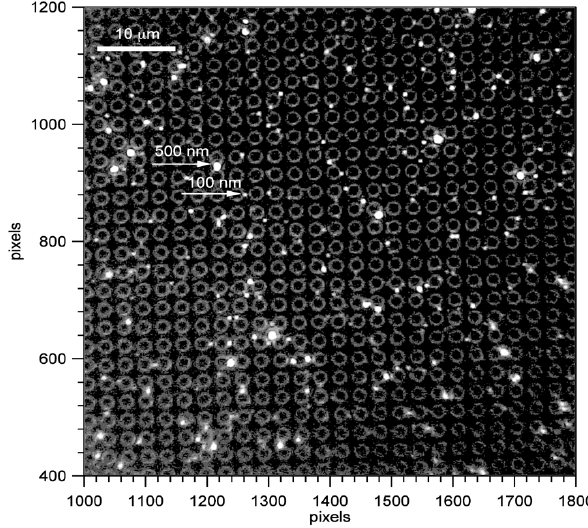
Figure 6 . Fig. 6. A still image taken during particle collection showing col- lected particles of 100nm and 500nm.